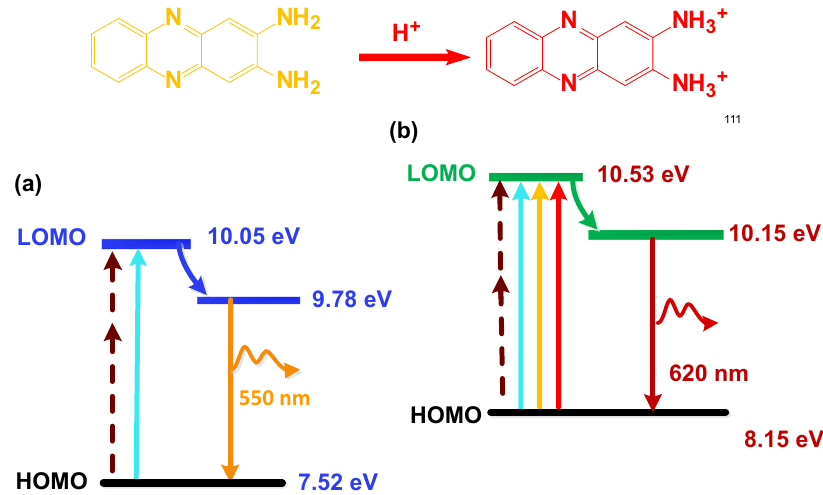
Fig. 8 Internal energy level variation of CDs by the protonation treatment. a CDs without the protonation; b CDs treated with the edge protonation.